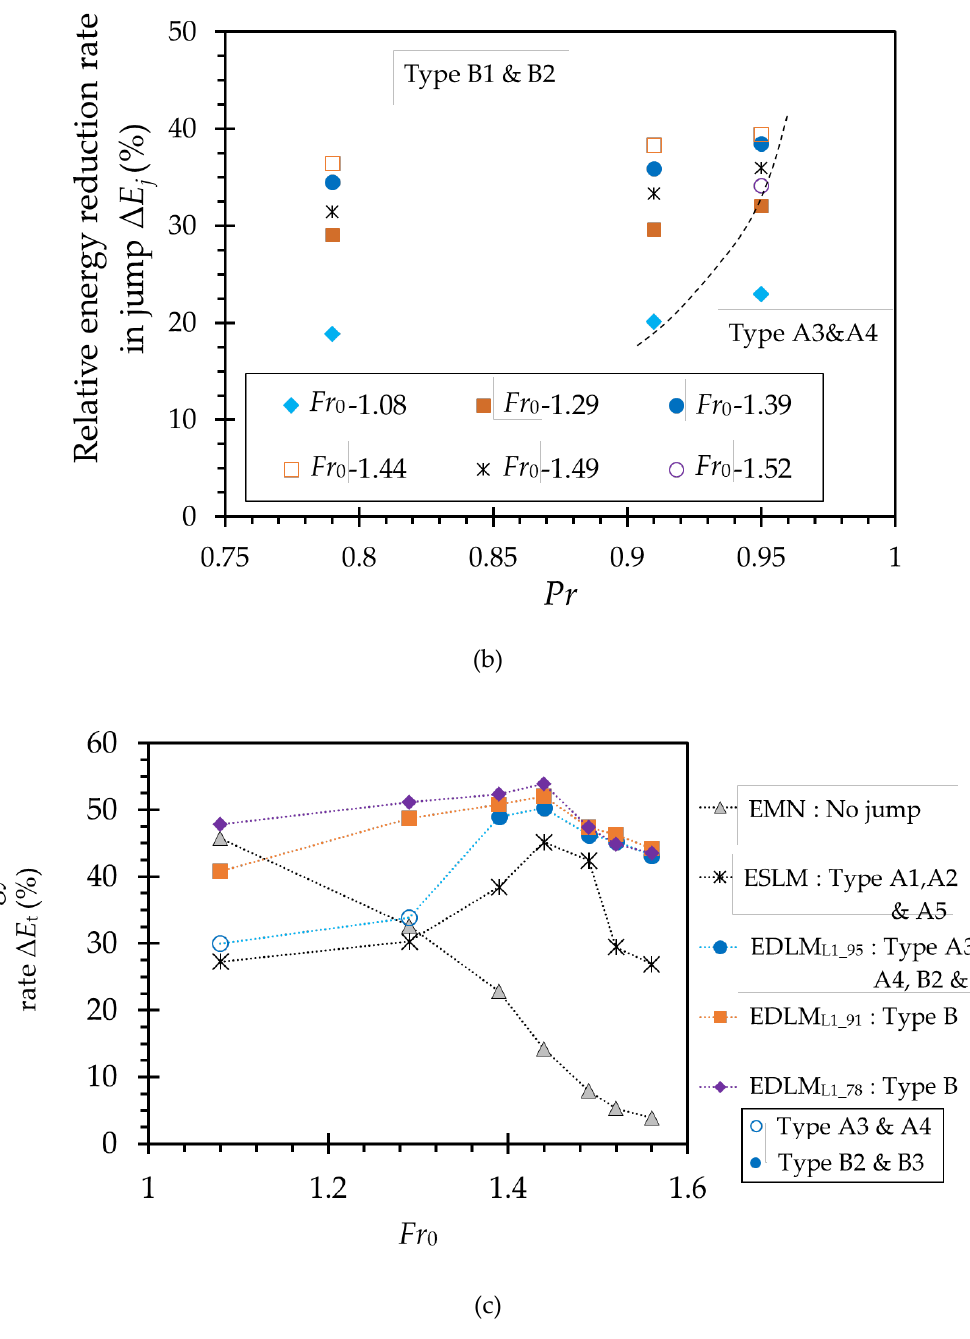
Figure 8. Relative energy reduction rate: ( a ) in hydraulic jump related to initial Froude number ( Fr 0 ), ( b ) in hydraulic jump related to the porosity of forest ( Pr ), and ( c ) total relative energy loss. (downstream of forest model) related to initial Froude number ( Fr 0 ).